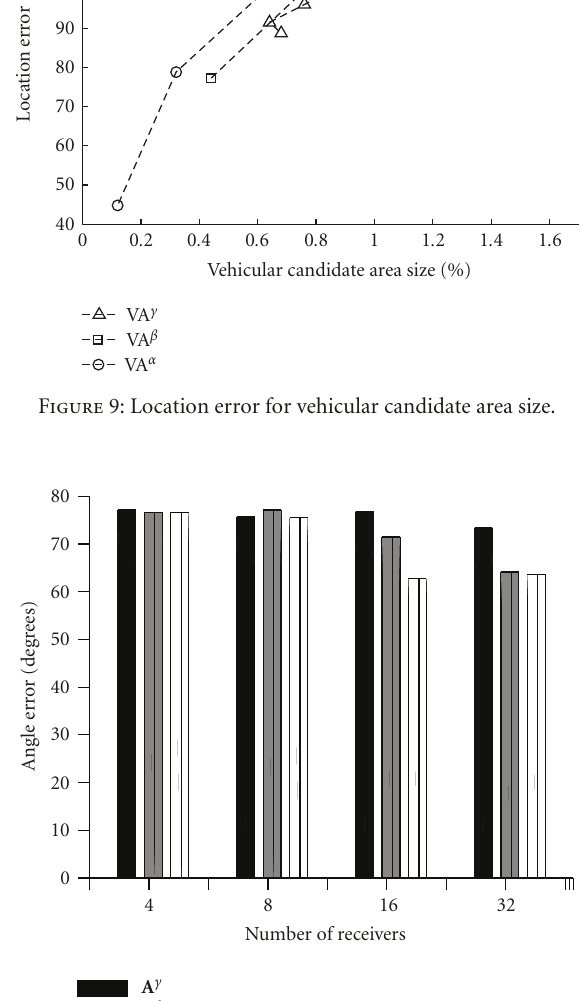
receivers, for confidence level C = 0 . 95, A β